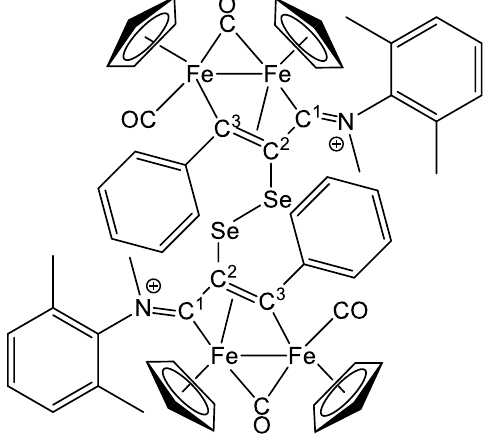
Chart 6. Structure of the cation of 4d .